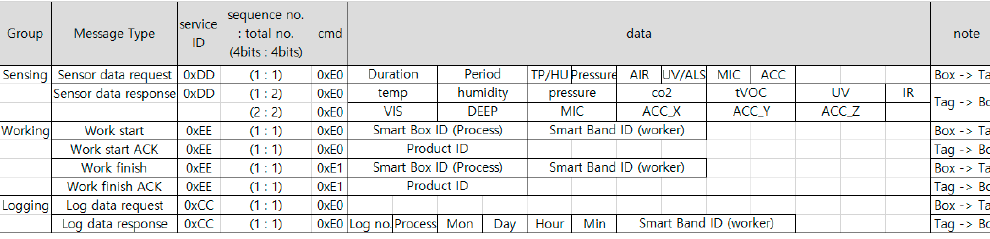
Figure 6. Communication protocol between the smart box and smart tag.